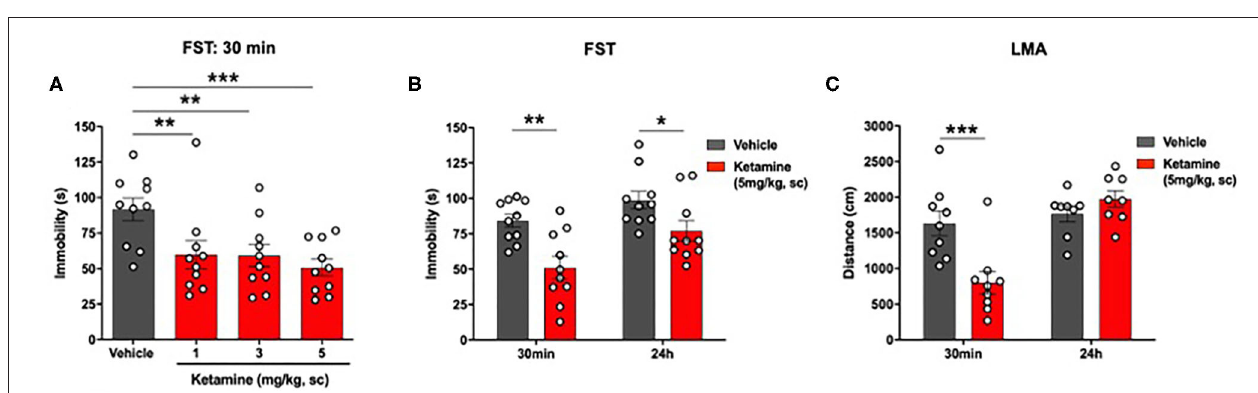
FIGURE 3 | Single administration of ketamine produced a rapid (30min) and sustained (24h) reduction in immobility in the FST and transiently reduced LMA (30min) in WKY rats. (A) Dose-response efficacy of acute ketamine (1, 3, and 5 mg/kg, s.c.) 30min post-administration in the FST. (B) FST 30min and 24h post-administration of ketamine (5 mg/kg, s.c.). (C) LMA 30min and 24h post-administration of ketamine (5 mg/kg, s.c.). Data are expressed as mean ± SEM, n = 8-10 per group. * p < 0.05, ** p < 0.01, *** p < 0.001. WKY, Wistar Kyoto; FST, forced swim test; LMA, locomotor